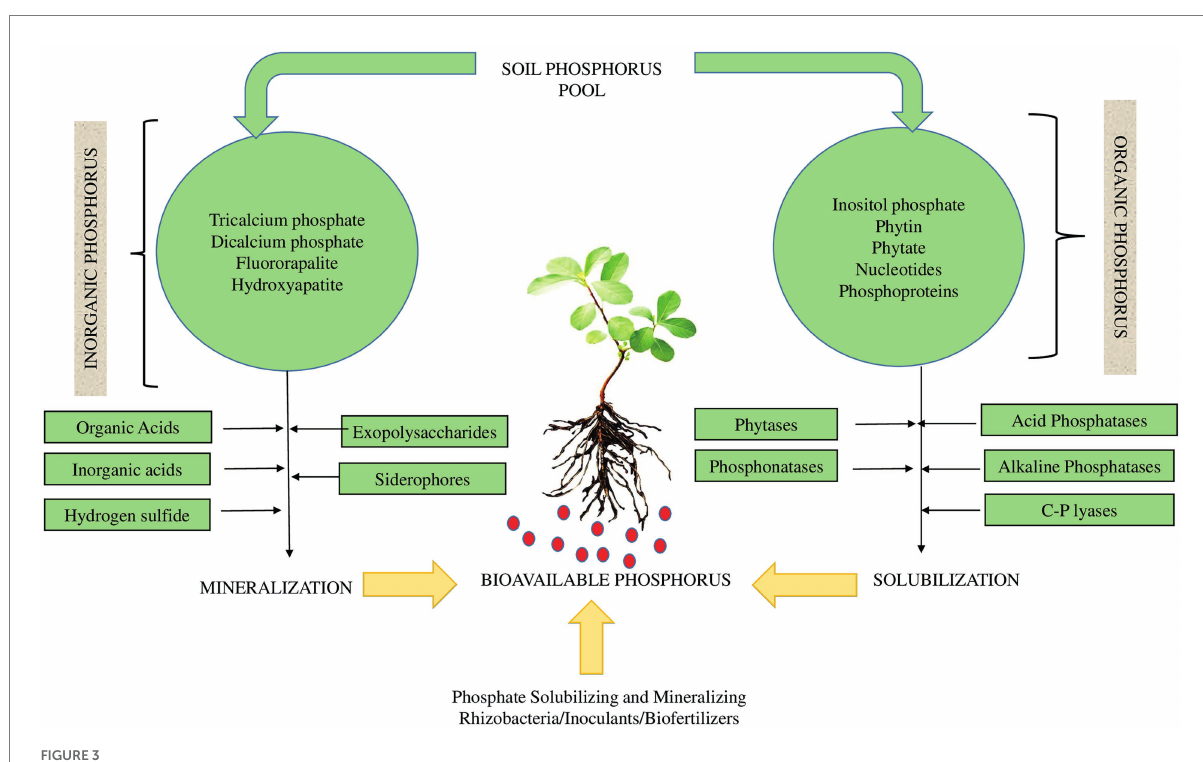
FIGURE 3 Phosphorus solubilization mechanisms depending on the types of available soil